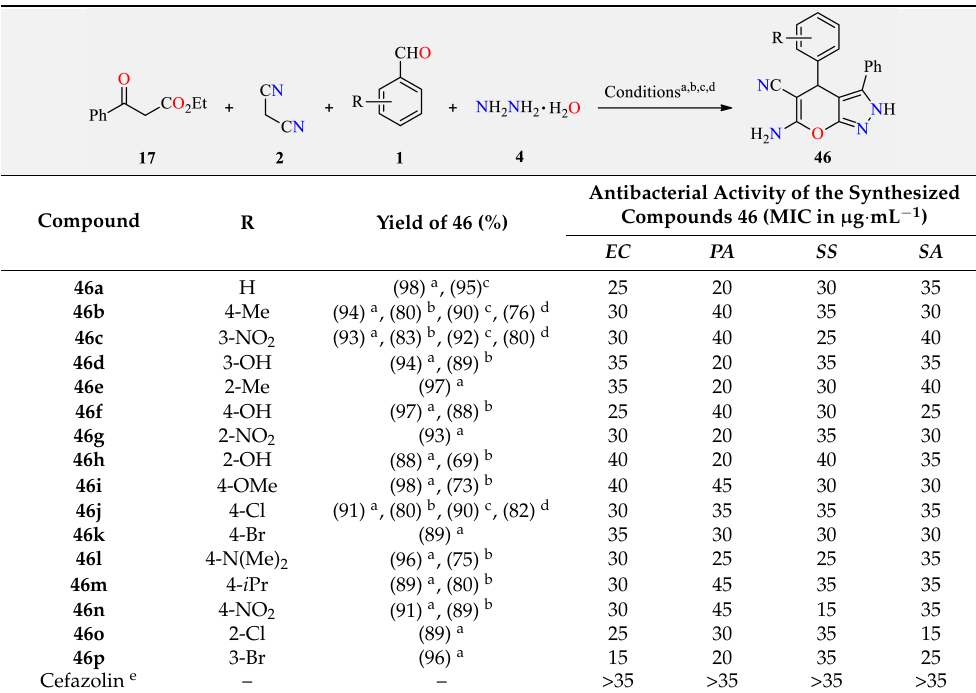
Table 11. Multicomponent synthesis and their in vitro antibacterial activity of pyranopyrazole deriva- tives 46 using ChCl • 2 thiourea and ChCl • 2 thiourea as catalysts, under both ultrasonic irradiation and reflux